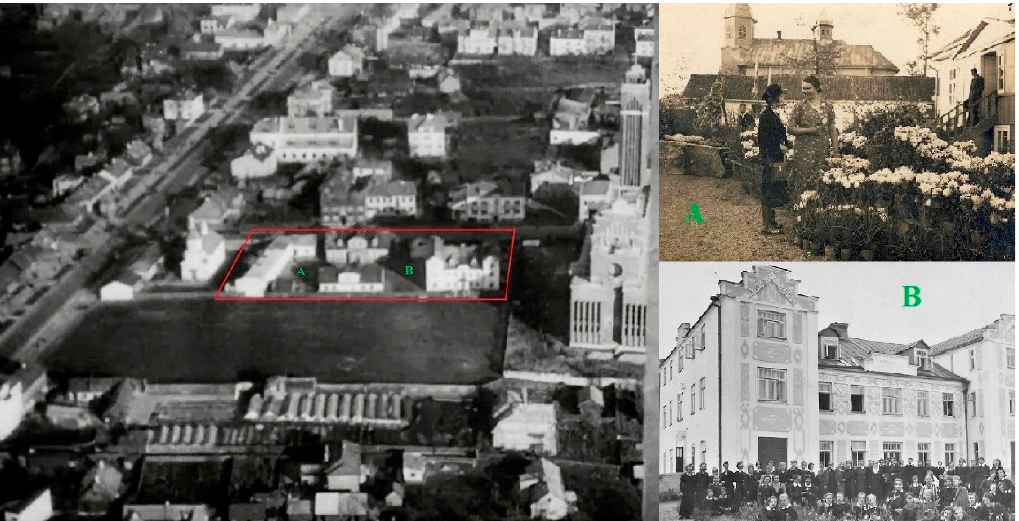
Figure 5. The plot of the Society of the Child Jesus is marked with red lines, and the buildings are marked with the letters (A) and (B) (source: Kupiškis Ethnographic Museum).